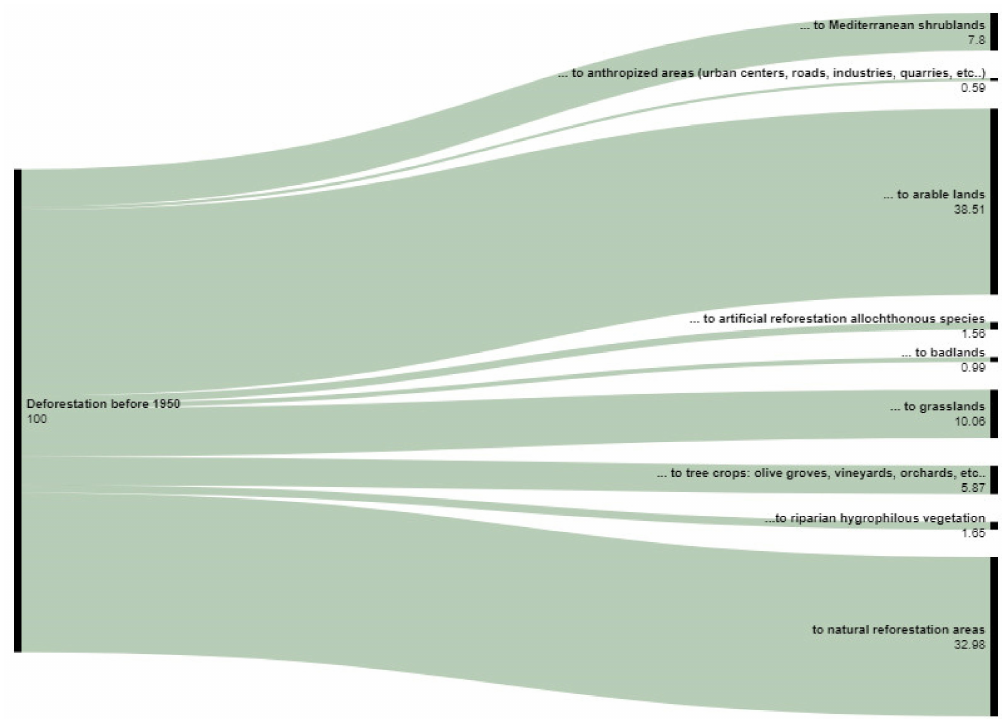
Figure 10. Sankey diagram for the dynamics of transformation of the forest area cleared before 1950 (deforestation area). The values are reported in percentage as in Table 7.